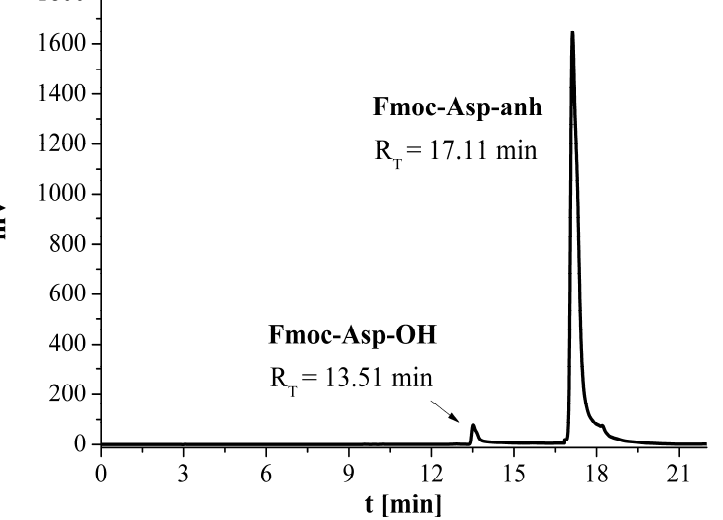
Figure 1. HPLC chromatogram (at 280 nm) of the reaction mixture of Fmoc-Asp-anh synthesis (R T = 17.11 min, gradient 1).